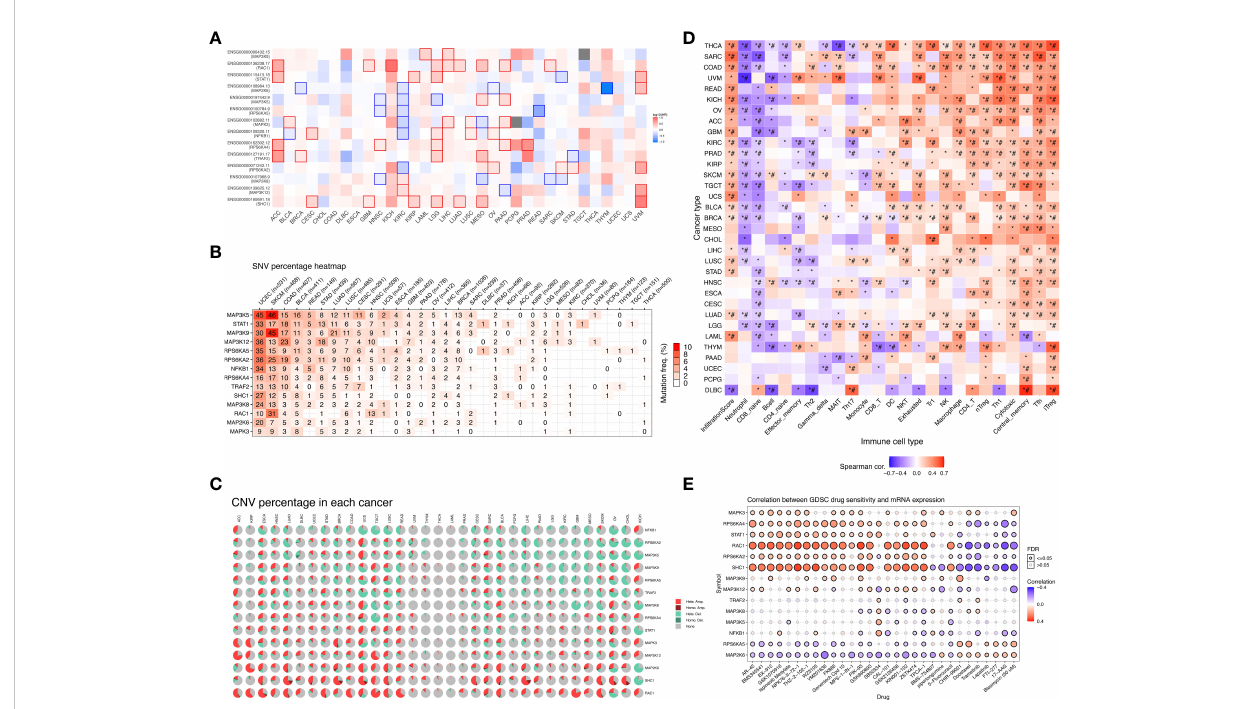
FIGURE 5 Overall survival analysis and variation analysis of this risk model gene in pan-cancer. (A) Overall survival analysis of this risk model gene in pan- cancer. Red represents this risk model gene as a risk factor, and blue represents this risk model gene as a protective factor. (B) SNV levels of 14 model genes in pan-cancer, where the darker the red color, the higher the probability of SNV. (C) CNV ratio of 14 model genes in pan-cancer, Light red hete amp represents heterozygous ampli fi cation, light green hete del represents heterozygous deletion, dark red Homo amp represents homozygous ampli fi cation, dark green Homo del represents homozygous deletion, and gray represents no CNV. (D) The GSVA method was used to analyze the level of immune cell in fi ltration in 33 different types of tumors, and the Spearman correlation coef fi cient was used to evaluate its correlation. Red indicates that the level of immune cell in fi ltration is positively correlated with the tumor. On the contrary, blue indicates a negative correlation. ( * P-value ≤ 0.05; # FDR ≤ 0.05). (E) In a sensitivity analysis of prognostic risk model gene mRNA expression and mainstream anticancer drugs, red represents a positive correlation, while blue represents a negative